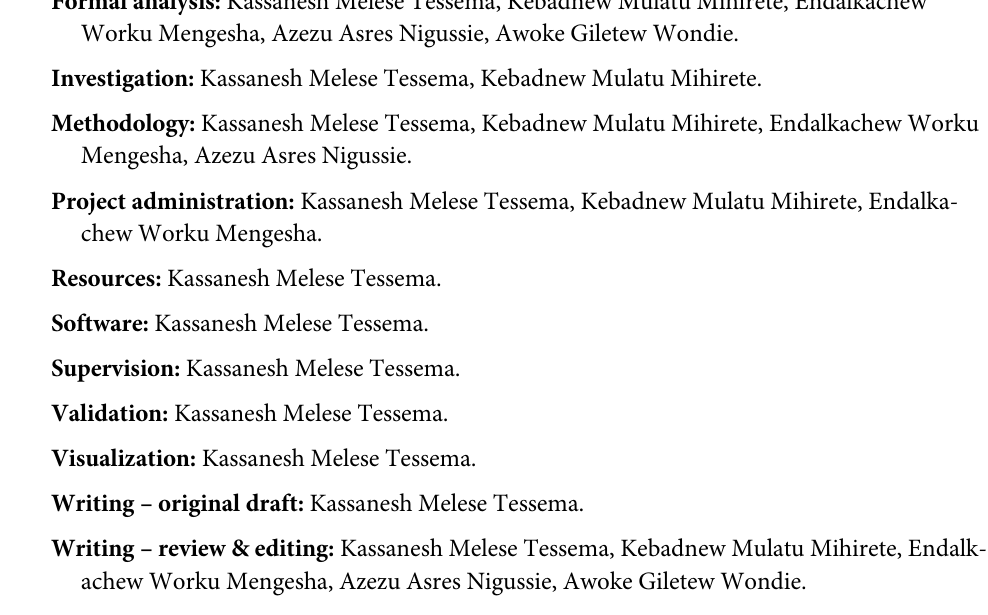
S1 Fig. Socio-cultural barriers for male partners’ involvement in institutional delivery in Debre Tabor town, North-West Ethiopia, 2019. S1 Table. Male partners knowledge on maternal health in Debre Tabor town, North-West Ethiopia, 2019 (n = 477). S2 Table. Male partners attitude towards institutional delivery in Debre Tabor town, North-West Ethiopia, 2019 (n =